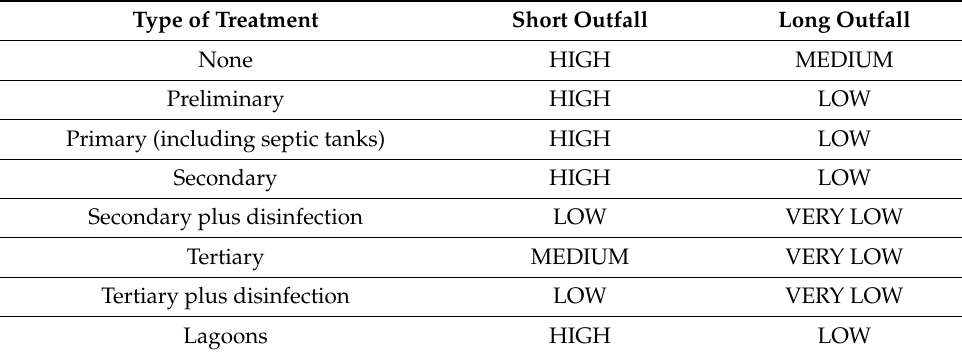
Table 1. Relative risk to human health associated with two types of wastewater discharges to the coastal marine environment. Modified from WHO